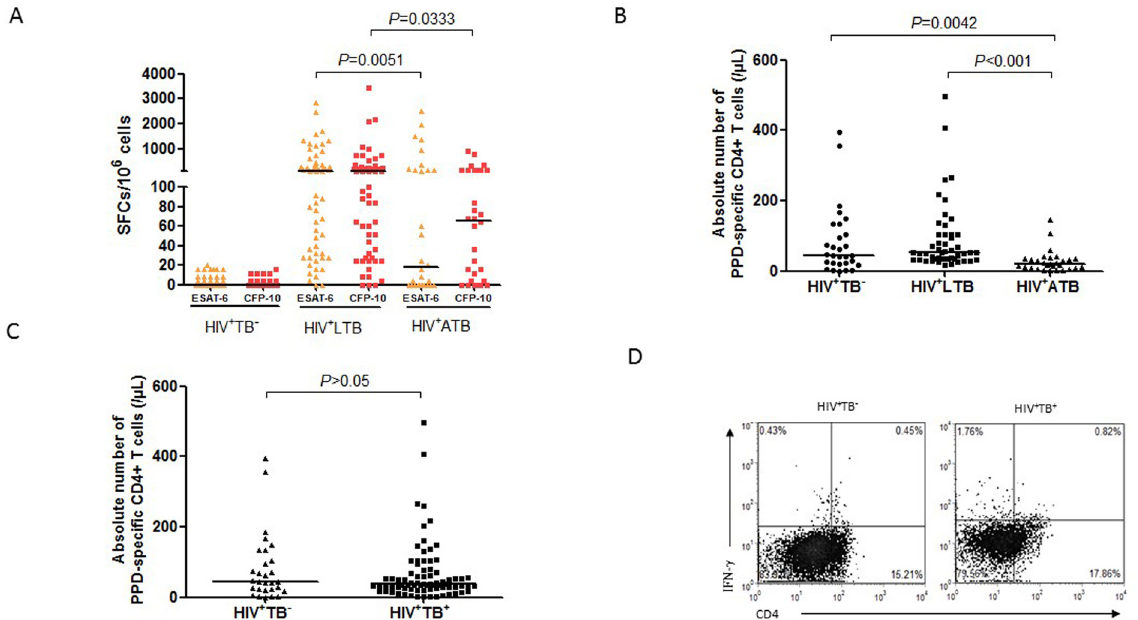
Fig 2. The absolute numbers of TB-specific IFN- γ + cells and CD4+ T effector cells in HIV-1 + individuals with different TB infection status. A . Spot- Forming Cells (SFCs) of ESAT6-/CFP10-specific IFN- γ + T cells in PBMCs in groups of HIV-1 + ATB, HIV-1 + LTB and HIV-1 + TB - . B . Numbers of PPD-specific IFN- γ +CD4+ T cells in groups of HIV-1 + ATB, HIV-1 + LTB and HIV-1 + TB - . C . Numbers of PPD-specific IFN- γ +CD4+ T cells in HIV-1 + individuals with or without M . tb co-infection (LTB+ATB). The horizontal lines represent the medians of cell numbers for each group. D . Representative CD3-gated histograms of PPD-specific IFN- γ +CD4+ T cells from cases of HIV-1 + TB + group and HIV-1 + TB - group.